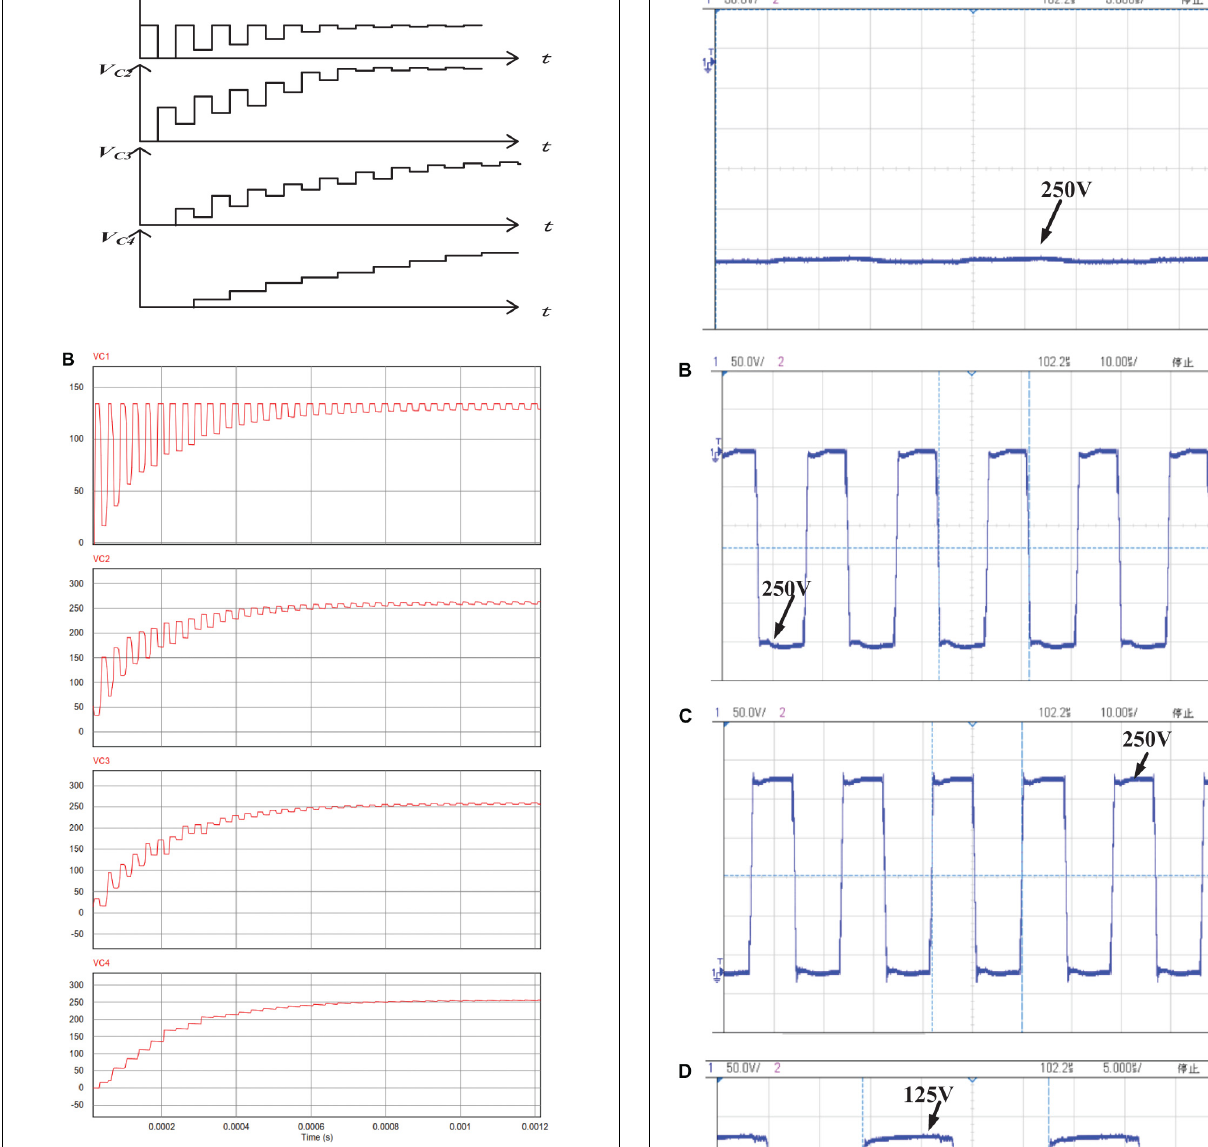
FIGURE 9 | Waveform for capacitors transient charging. (A) Theoretical waveforms for capacitors transient charging. (B) Simulation waveforms for capacitors transient charging.